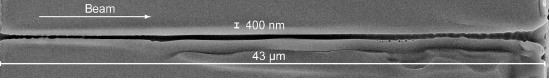
Figure 19: SEM image of a through channel with a diameter of about 400 nm formed in 43- µ m thick glass (aspect ratio: > 100) by a fem- tosecond Bessel pulse [140]. Reproduced with permission from The